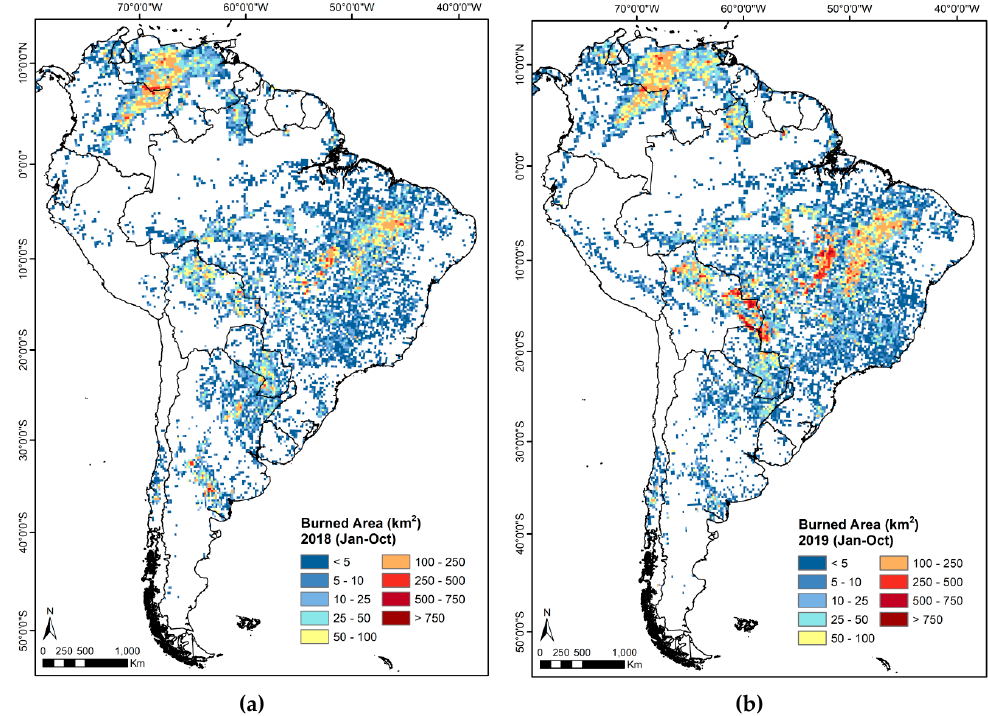
Figure 3. Spatial distribution of BAs in South America in 2018 ( a ) and 2019 ( b ).